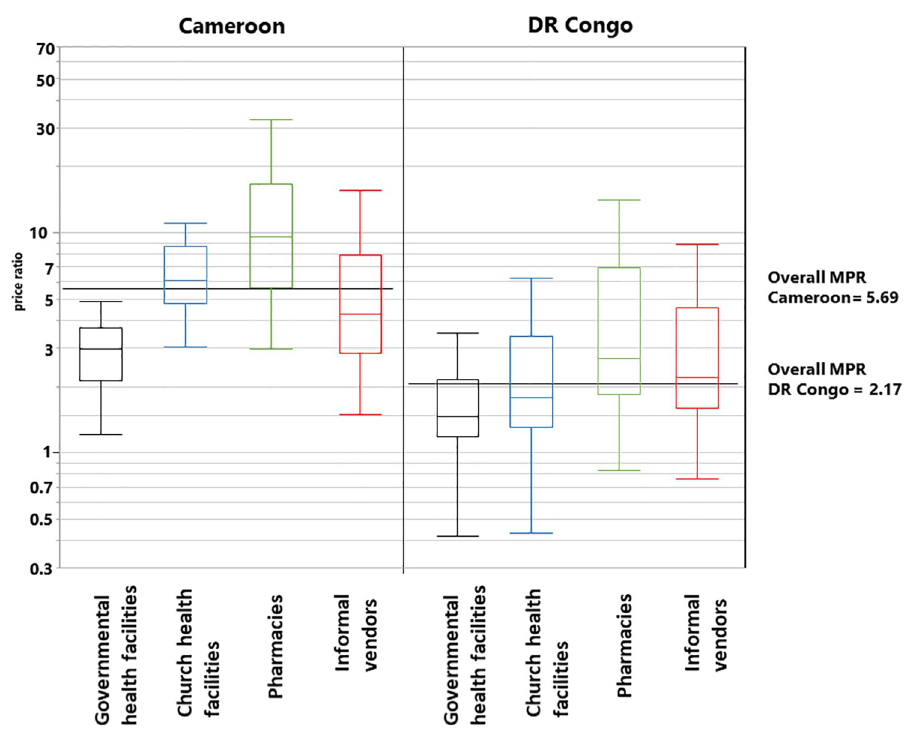
Fig 3. Boxplots of the price ratios in the four different types of facilities.